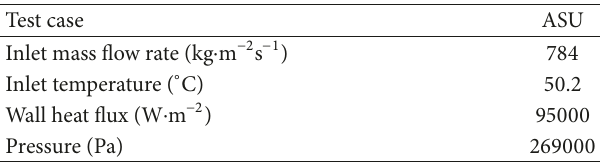
Figure 57: ASU liquid temperature with the new and standard